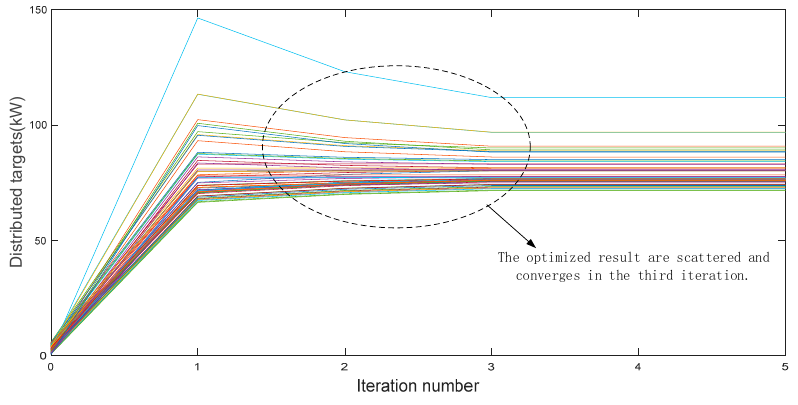
Figure 17. 60 CACs Data distribution process with the interior point method.